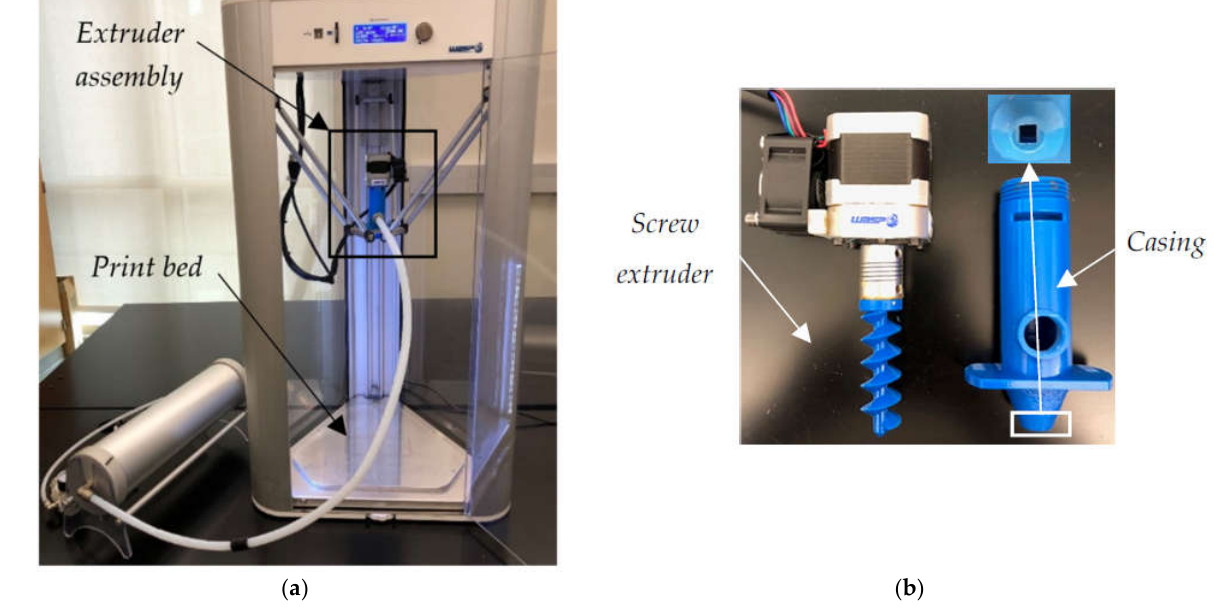
Figure 4. Material-extrusion 3D printer: ( a ) Delta WASP 2040 printer; ( b ) extruder assembly, including screw extruder and casing with a square cross-section measuring 6 × 6 mm.